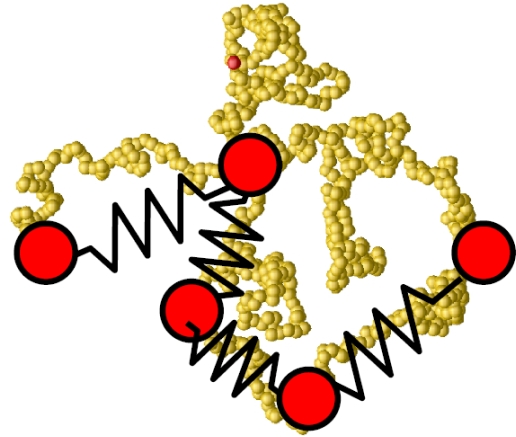
A coarse-grained model of a polymer chain where some groups of the detailed atomic structure (yellow beads) is lumped into one coarse-grained particle (red). The individual particles are connected by springs (bead-spring model).